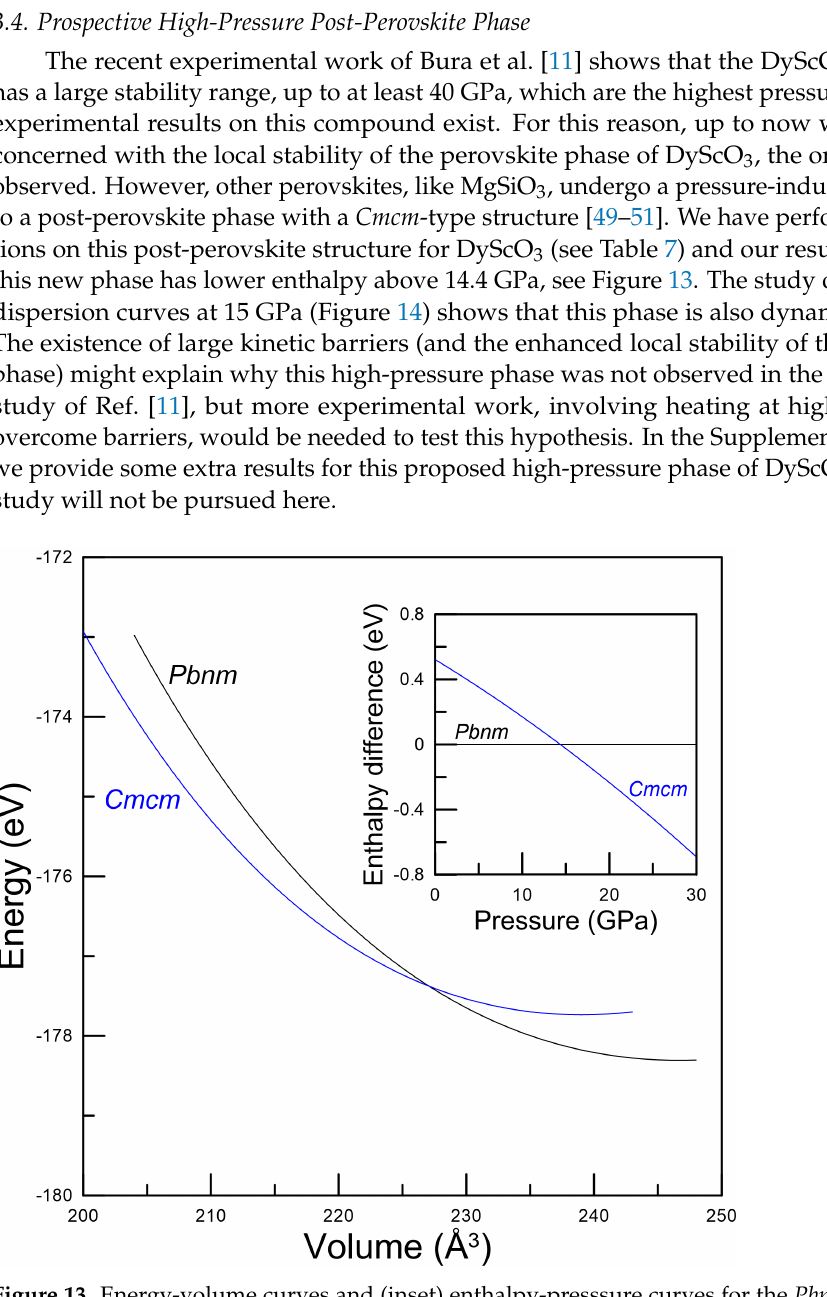
Figure 13. Energy-volume curves and (inset) enthalpy-presssure curves for the Pbnm (perovskite) and Cmcm (post-perovskite) phases of DyScO 3 (black and blue curves, respectively). The enthalpies are given with respect to that of the perovskite